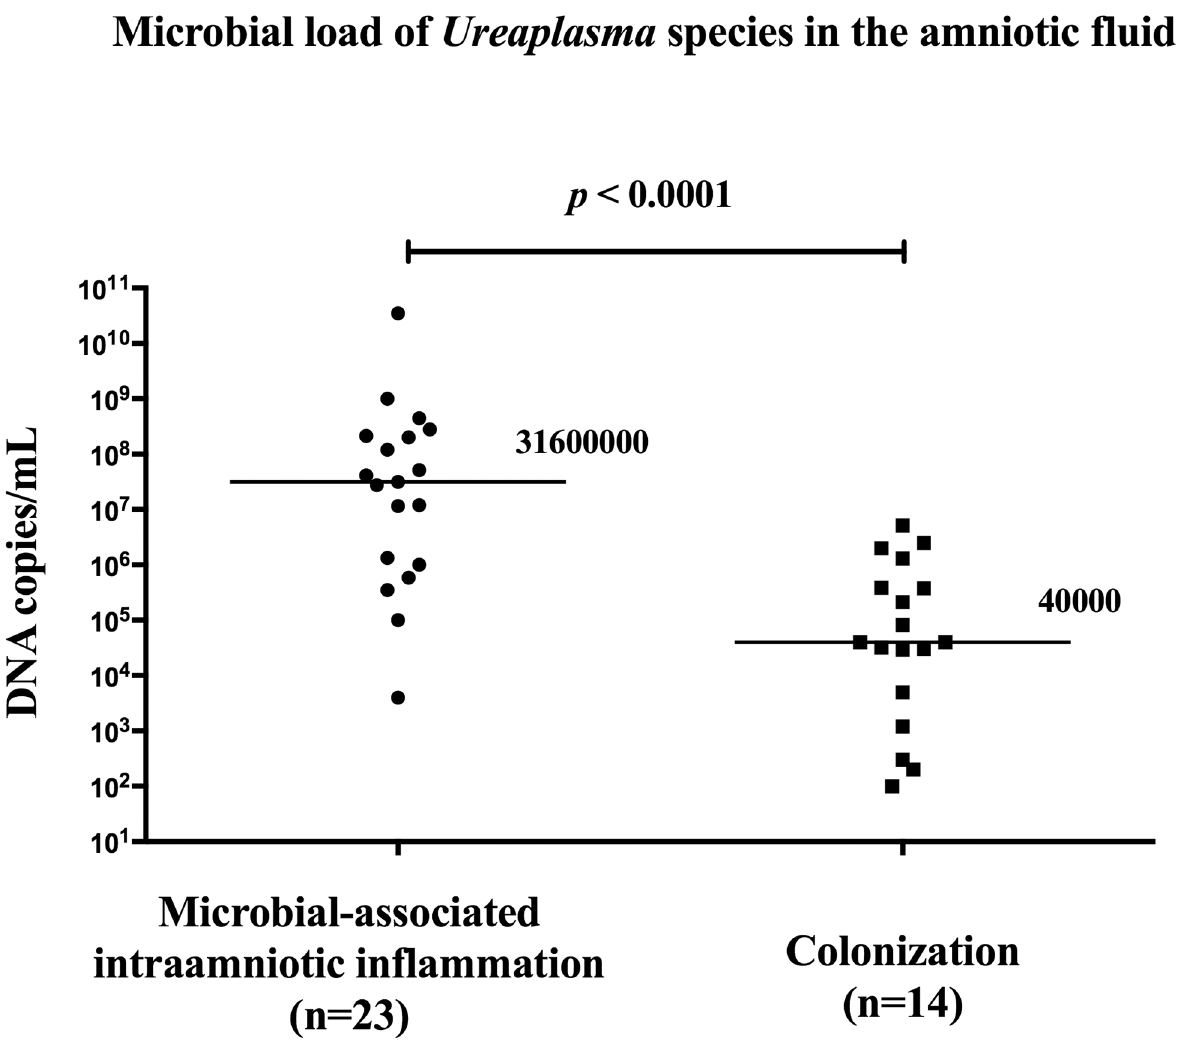
Fig 5. Amniotic fluid microbial loads of Ureaplasma species in preterm prelabor rupture membrane pregnancies that are complicated by the microbial-associated intraamniotic inflammation and microbial invasion of the amniotic cavity